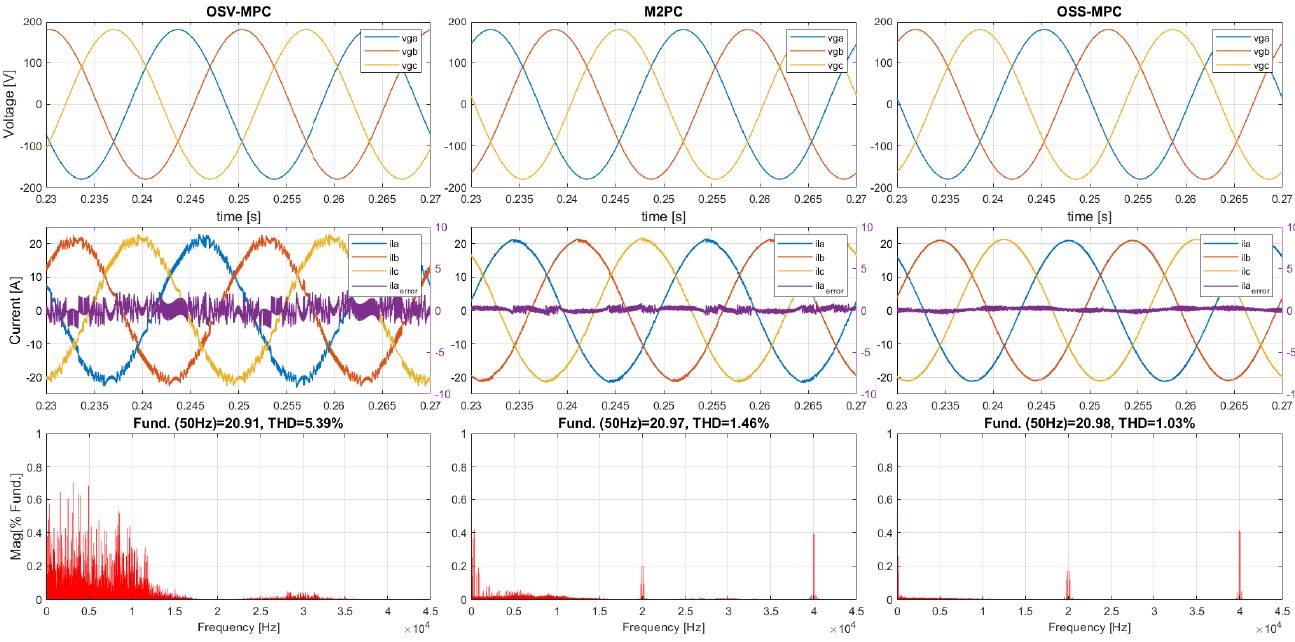
Figure 14. Output voltage, current, and current spectrum for each FCS-MPC technique for 𝑃 ∗ = 4 kW, 𝑄 ∗ = 4 kVAr.